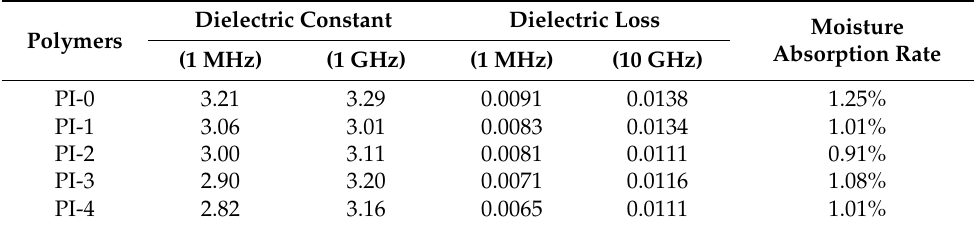
Figure 7. Water contact angles of the PI films. Table 6. Dielectric properties and moisture absorption rate of PI Table 6. Dielectric properties and moisture absorption rate of PI films.